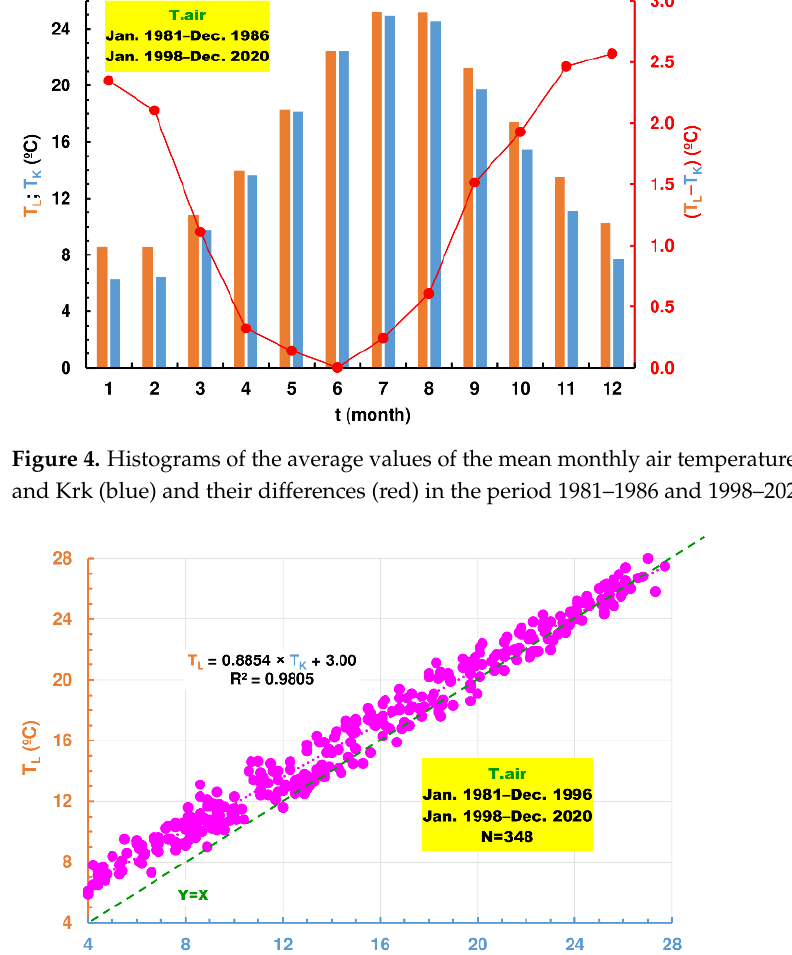
Figure 5. Relationship between the mean monthly air temperatures at Lastovo (ordinate axis) and Krk (abscissa axis) from January 1981 to December 1986 and from January 1998 to December 2020.